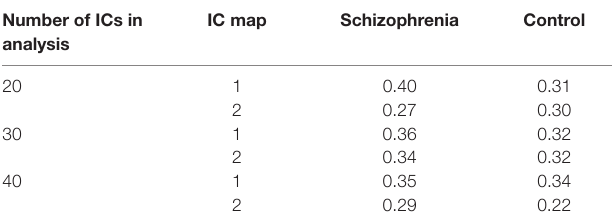
TaBle 3 | correlation of independent component (ic) maps from group ica analysis with default mode network template. number of ics in ic map schizophrenia control analysis